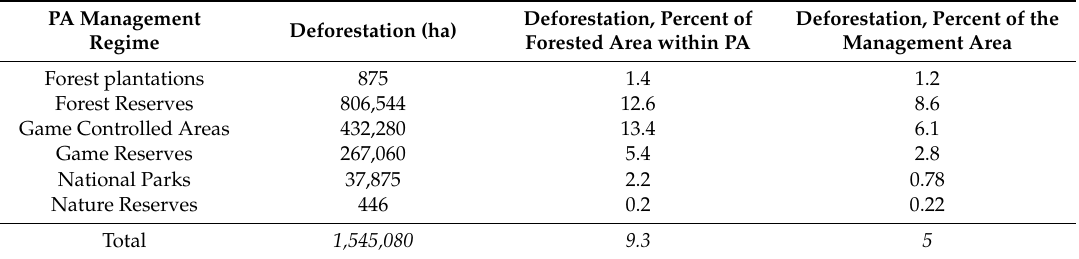
Table 2. Summary of PA characteristics: number and size of PAs, total 11 years (2002–2013) deforestation (ha), and area deforested as percentage of PAs total management area, and PA forest area at the beginning of monitoring